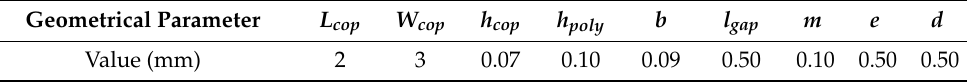
Table 2. Numerical values of the geometrical parameters used in the modelling. Geometrical Parameter L